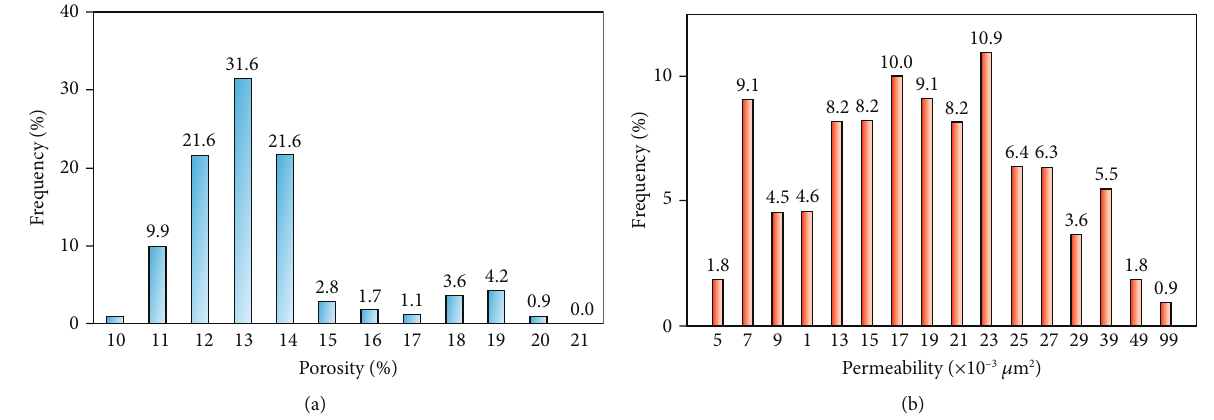
Figure 5: The frequency of (a) porosity and (b) permeability of the Yan 9 32 layer. Table 1: Con fi guration classi fi cation of meandering river facies reservoir in the study area.